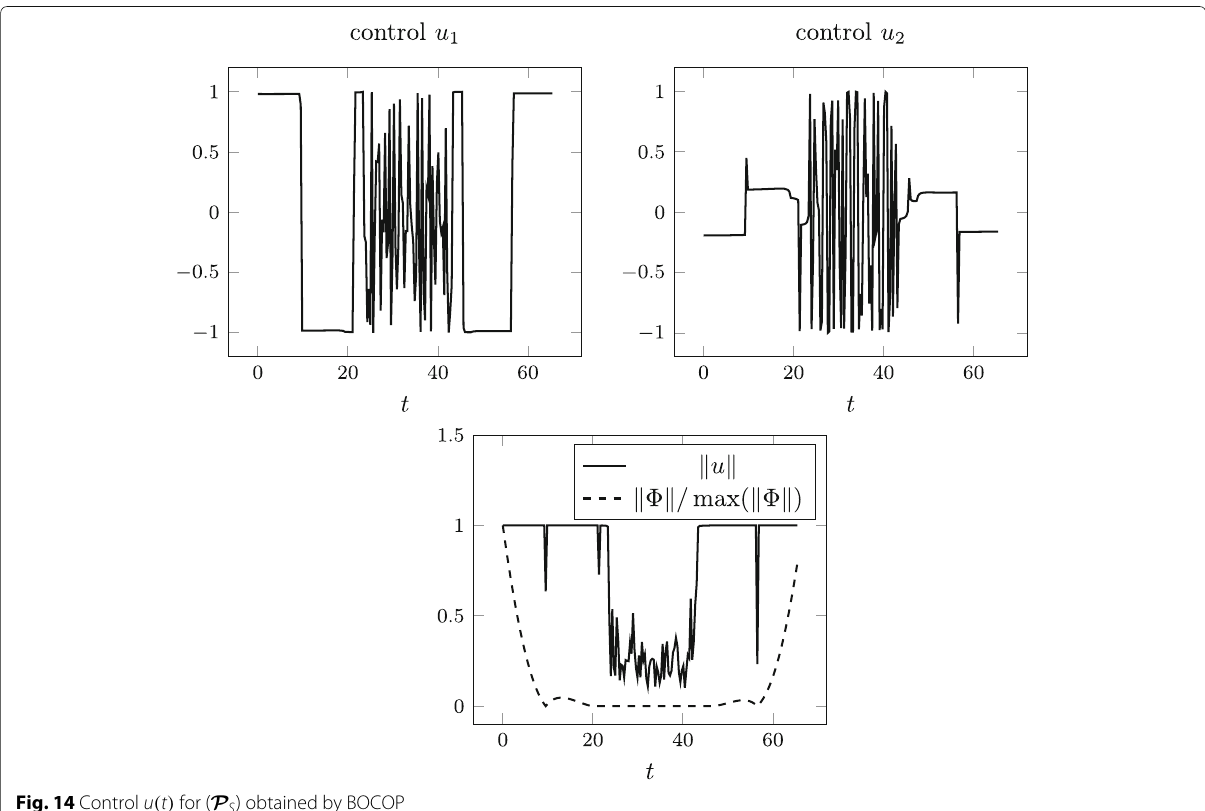
Fig. 14 Control u ( t ) for ( P S ) obtained by BOCOP